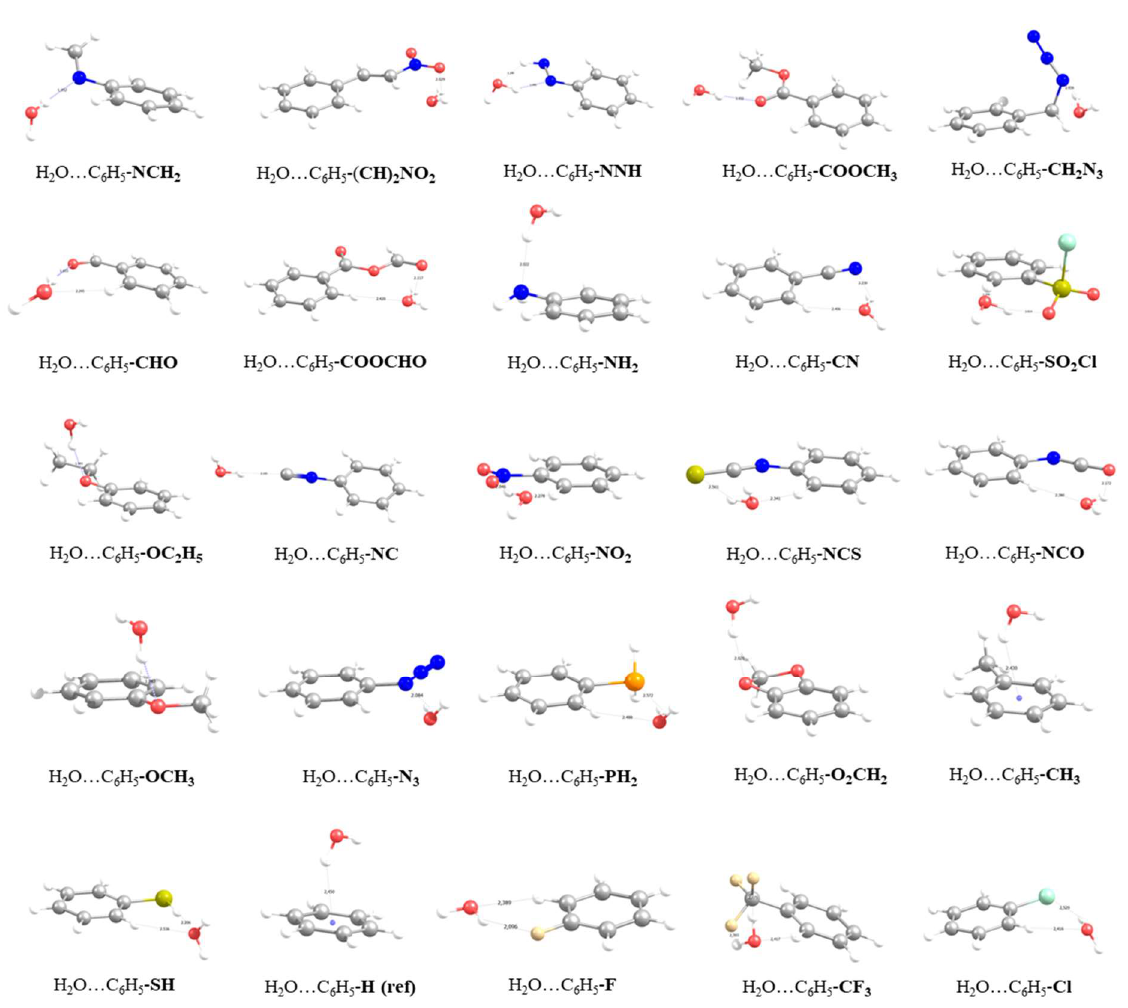
Figure 2. Optimized geometries at the RIMP2/def2-TZVPP-level of theory for the second subset of 25 functionalized benzenes. 3.2. GCMC Simulations for H 2 O Uptake in Functionalized Mg-MOF-74-III